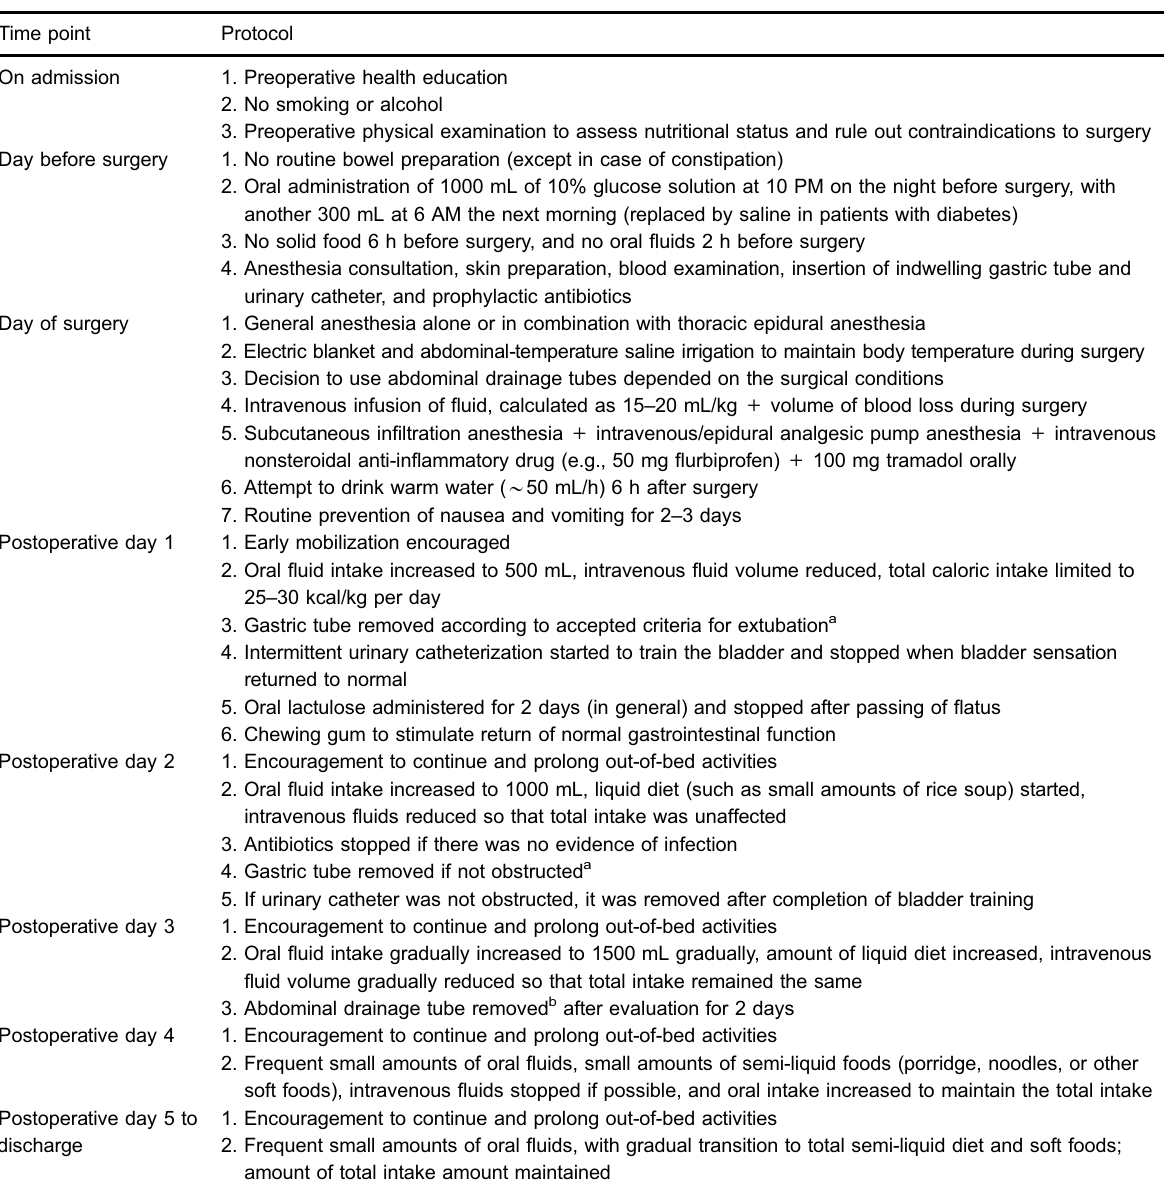
Table 1. Enhanced recovery after surgery (ERAS)